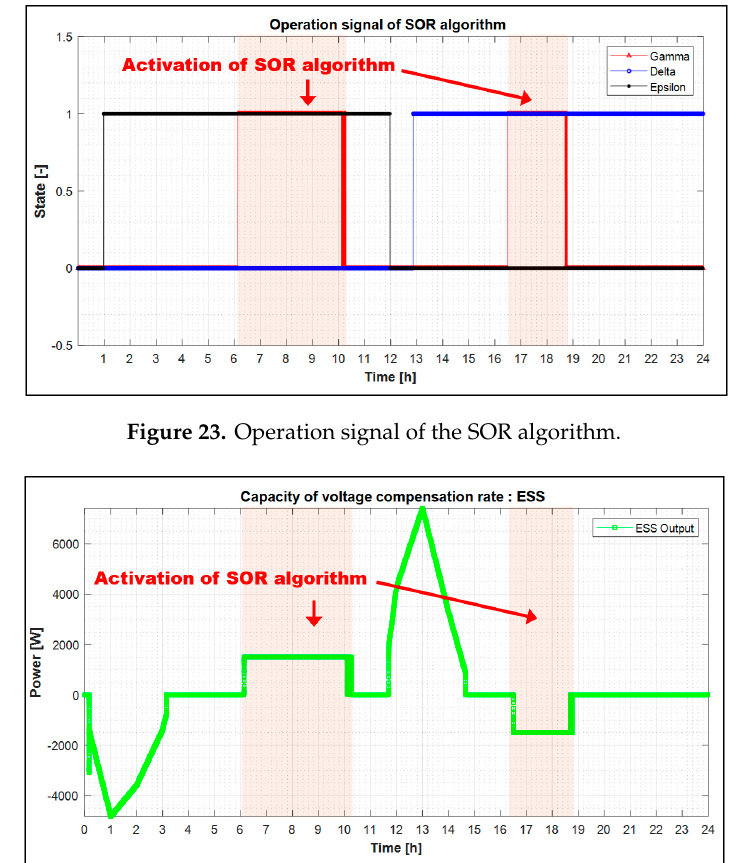
Figure 24. Capacity characteristic by operation of the SOR algorithm.